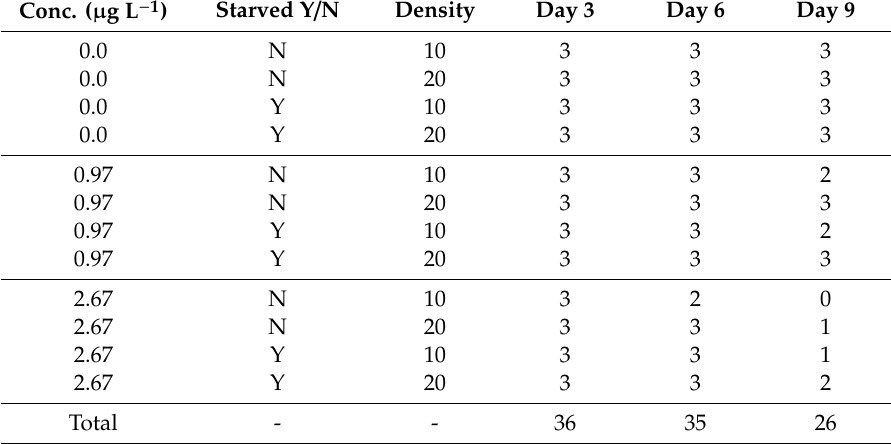
Table 1. Numbers of replicate experimental units (with at least one alive animal) remaining for each treatment combination across sampling dates. Note that the response ‘moulting frequency’ was calculated using the sample size of the previous sampling date (three days earlier); therefore, sample sizes for this response variable are equal to that of the previous